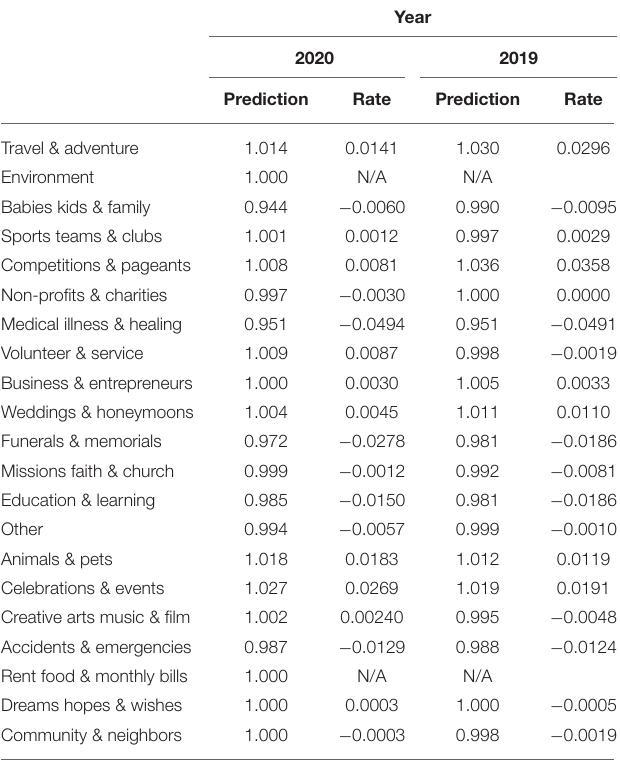
TABLE 5 | Counterfactual analysis experiment for categories.